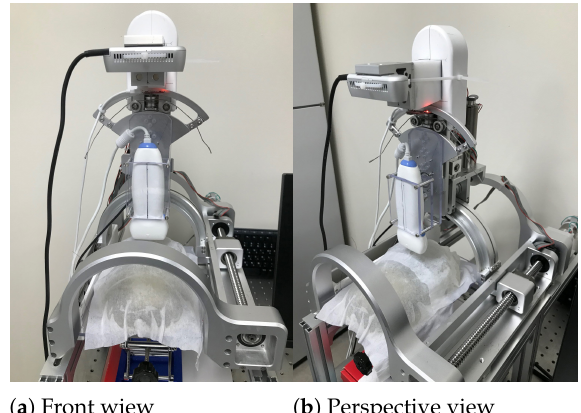
Figure 8. In-vitro test pictures.